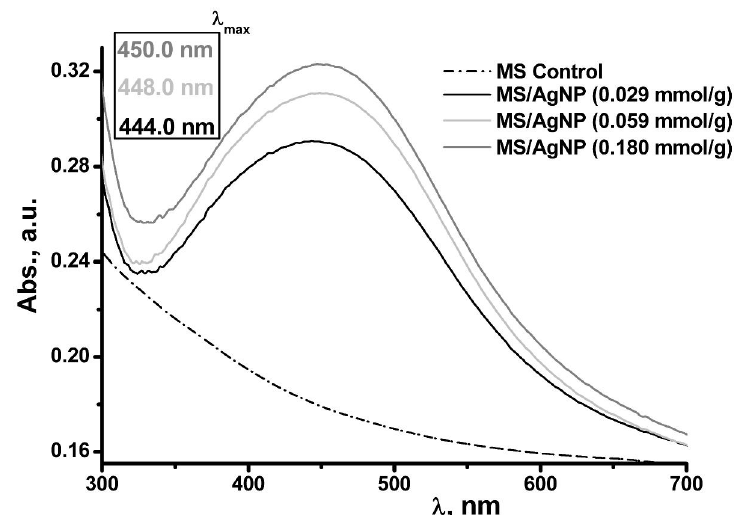
Figure 5. DRUVs analysis of MS/AgNP materials prepared at increasing Ag loading ( surface plasmon maxima ( λ ) indicated max